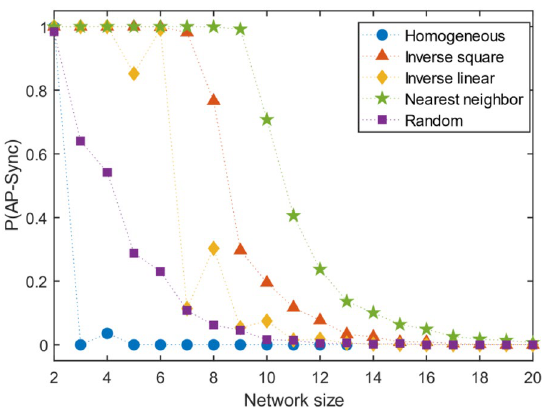
Figure 9. Fixed time ( = t 100 ) probability of AP synchronization. The fraction of the random initial conditions that can AP synchronize for regular graph networks falls with network size for fixed time. In real networks, this would allow other faster dynamical interactions (within the oscillator or with the environment, etc.), if any, to affect the formation of the AP synchronized steady